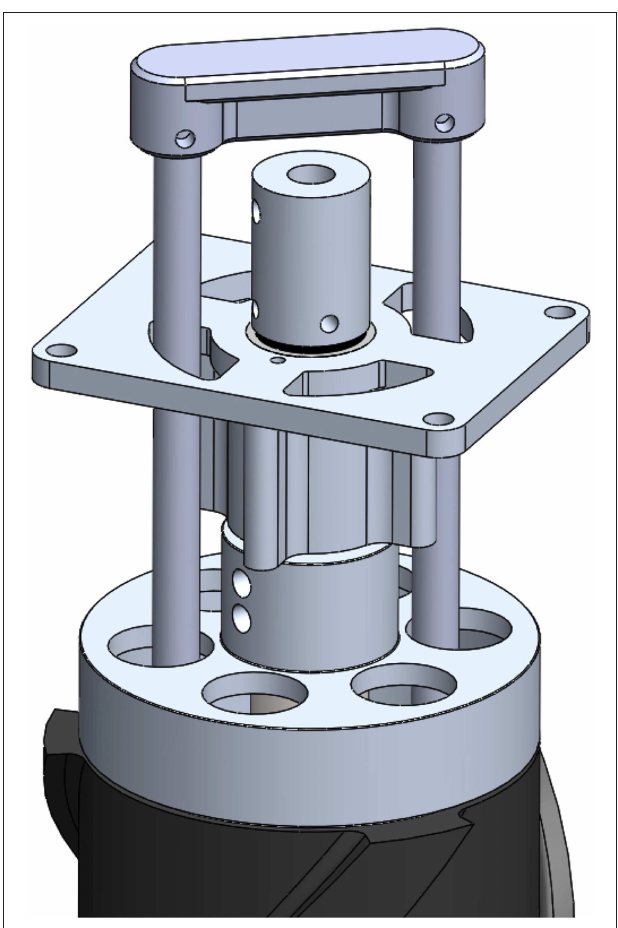
FIGURE 4 | An extraction tool uses two aluminum rods that fit through holes at the top of the drill to remove the ice sample.